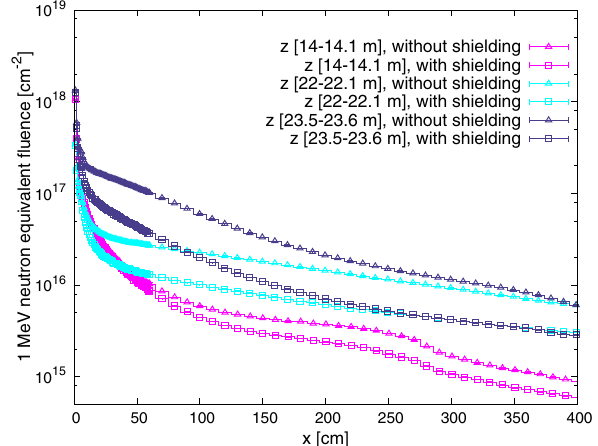
FIG. 14. Neutron fluence rate for an instantaneous luminosity of 30 × 10 34 cm − 2 s − 1 in the presence of the shielding described in the text: top view. The same scoring resolution as the one of Fig. 9 has been adopted, except for the endcap muon chamber region, where the average on y has been done on a bin of about 1.3 m for j x j > 0 . 6 m.